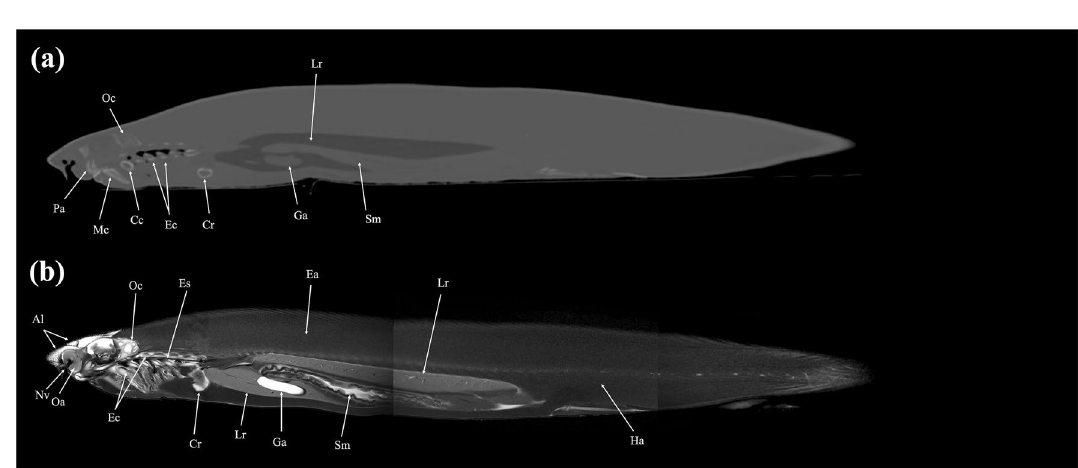
Figure 15. Sagittal ( a ) CT and ( b ) MR images of a banded houndshark ( Triakis scyllium ) at level 15 of Fig. 25. Al Ampullae of Lorenzini, Cc Ceratohyal cartilage, Cr Coracoid bar, Ec Epibranchial and ceratobranchial cartilage, Es Esophagus, Ga Gall bladder, Mc Meckel’s cartilage, Oa Olfactory lamellae, Oc Otic capsule, Pa Palatoquadrate, Sm Stomach, Nv Nasal